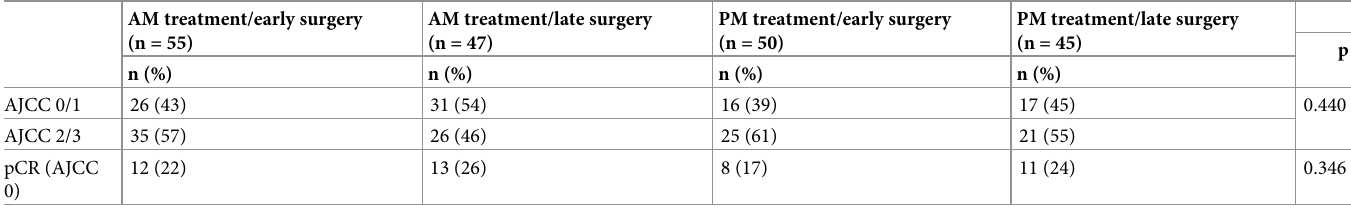
Table 4. Tumour regression in composite time of treatment/time to surgery groups. AM treatment/early surgery (n = 55)